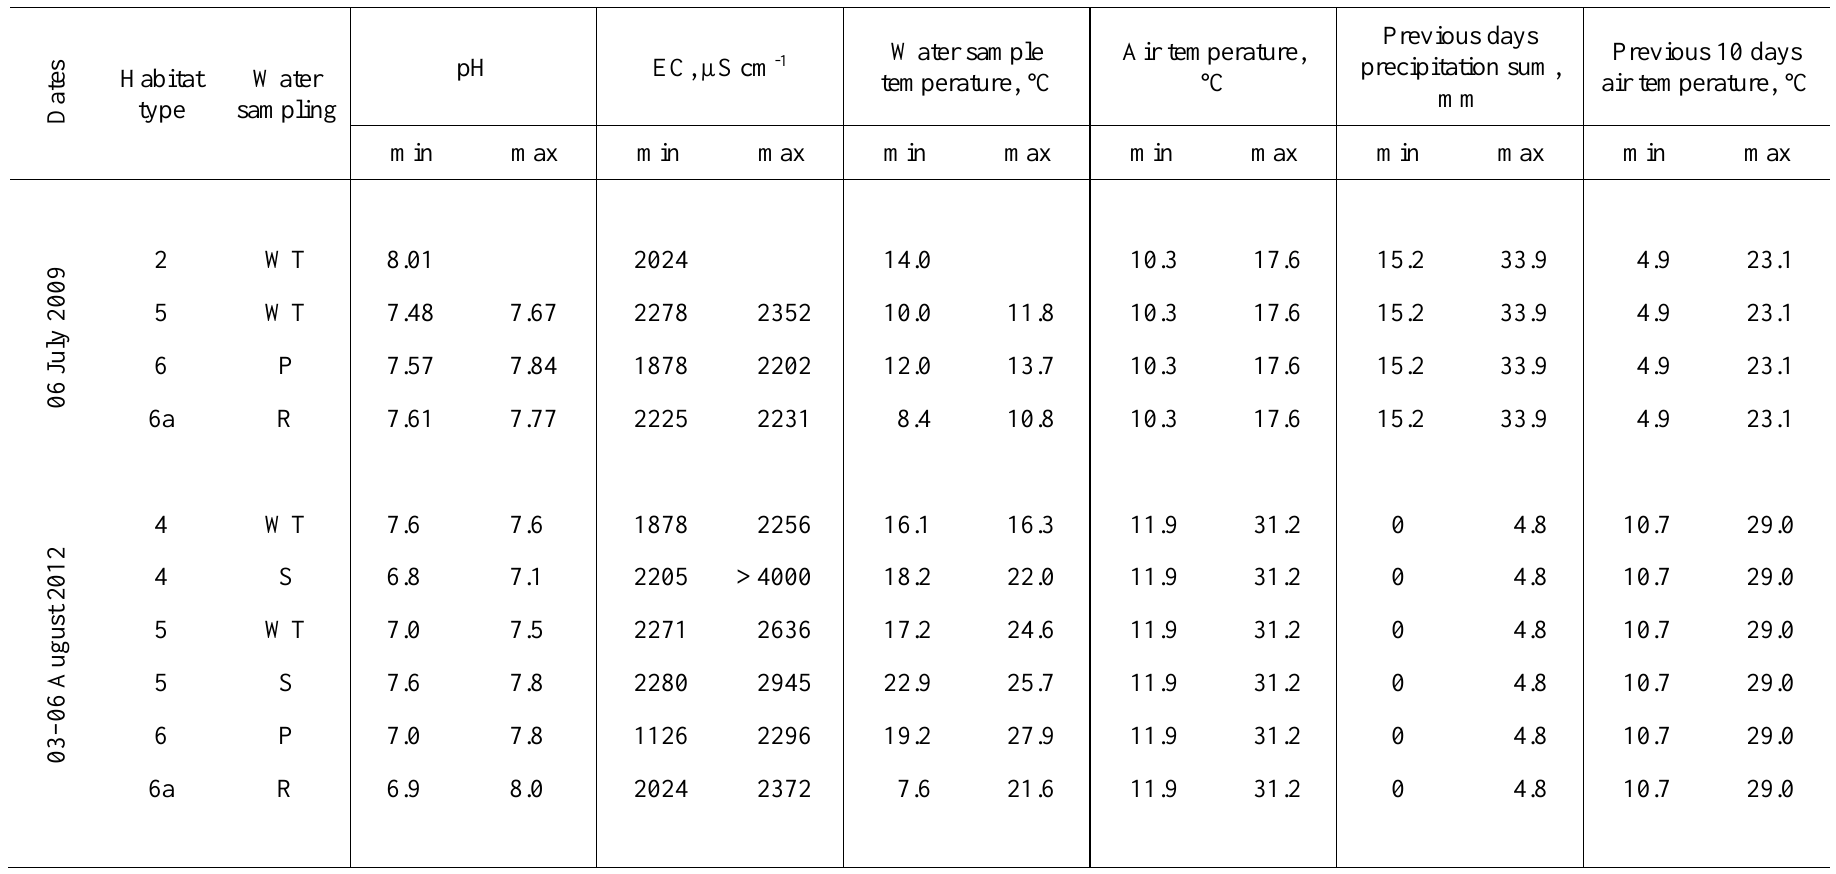
Table 1. Summary of the measurements of physical and chemical characteristics of mire water water in the different habitats of the “Arkaulovskoye Mire” Protected Area, Republic of Bashkortostan, Russia. Habitat types: 1 = sedge - reed birch and birch - alder forested mire, 4 = moss - shrub dwarf pine forested mire, 5 = Schoenus ferrugineus - small sedges - brown mosses open mire, 6 = small pools, 6a = streams. Sample types: WT = at the mire water table; S = squeezed from the surface moss cover; P = at the surface of a pool; R = at the surface of a